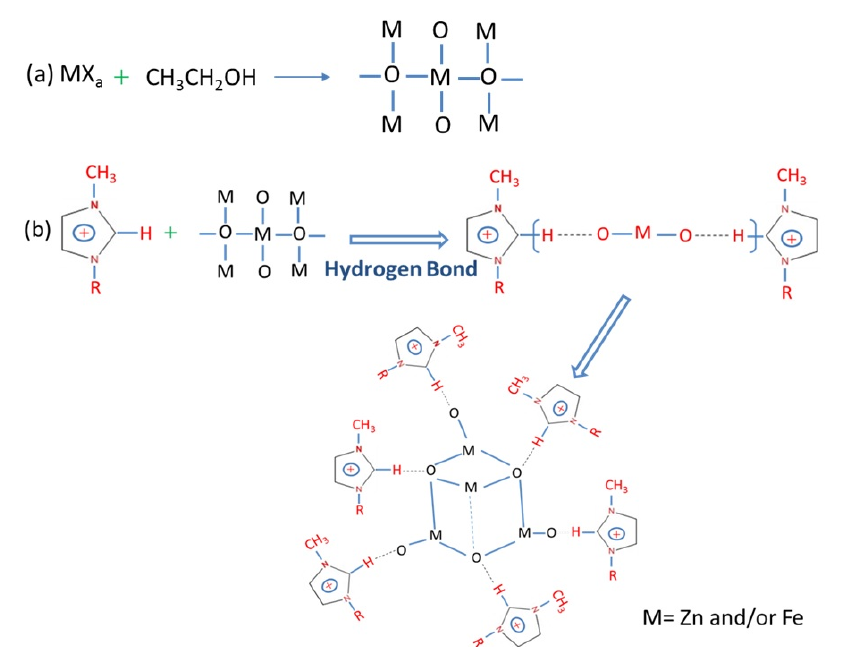
Figure 2. Schematic illustration of the preparation process of the ZnFe